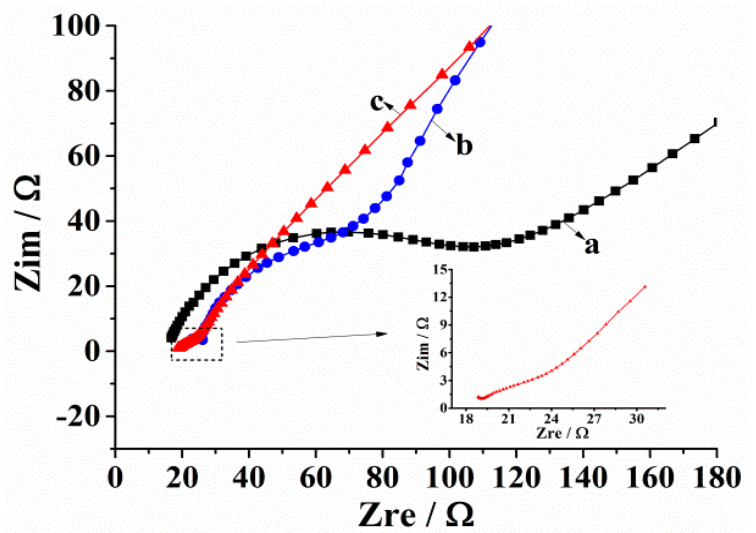
Figure 5. Electrochemical impedance spectroscopy of bare GCE (a), AB–DHP/GCE (b) and AuNPs/AB–DHP/GCE (c) in 5 mM Fe(CN) 63 − /4 − and 1 M KCl solution.